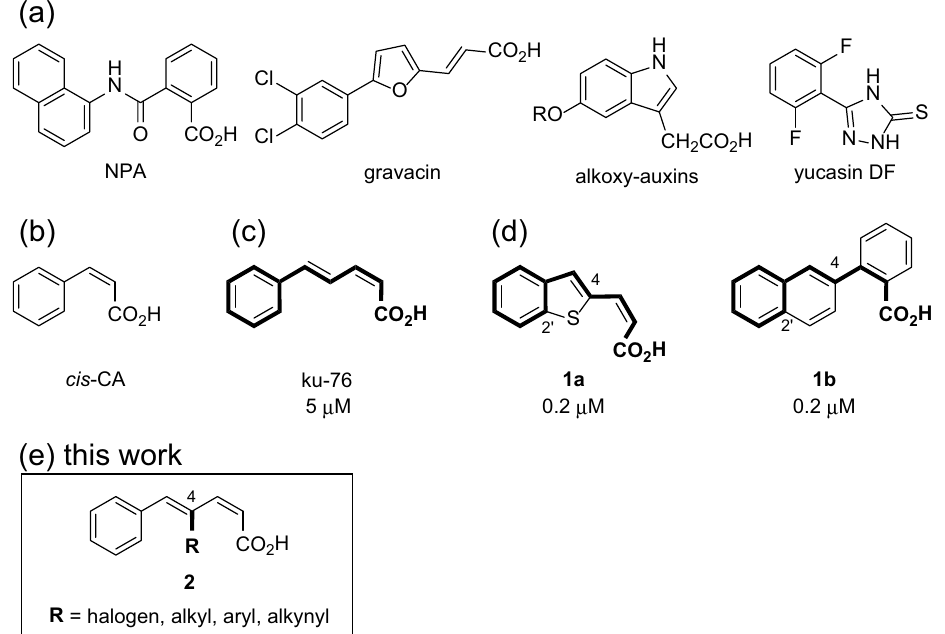
Figure 1. Structure of reported gravitropic inhibitors. ( a ) Non-selective gravitropic inhibitors of both elongation and gravitropic bending: NPA, gravacin, alkoxy-auxins, and yucasin DF ( b ) cis -CA. ( c ) ku-76. ( d ) More potent analogs, 1a and 1b , were reported previously. ( e ) C4-substituted ku-76 analogs that were synthesized in this